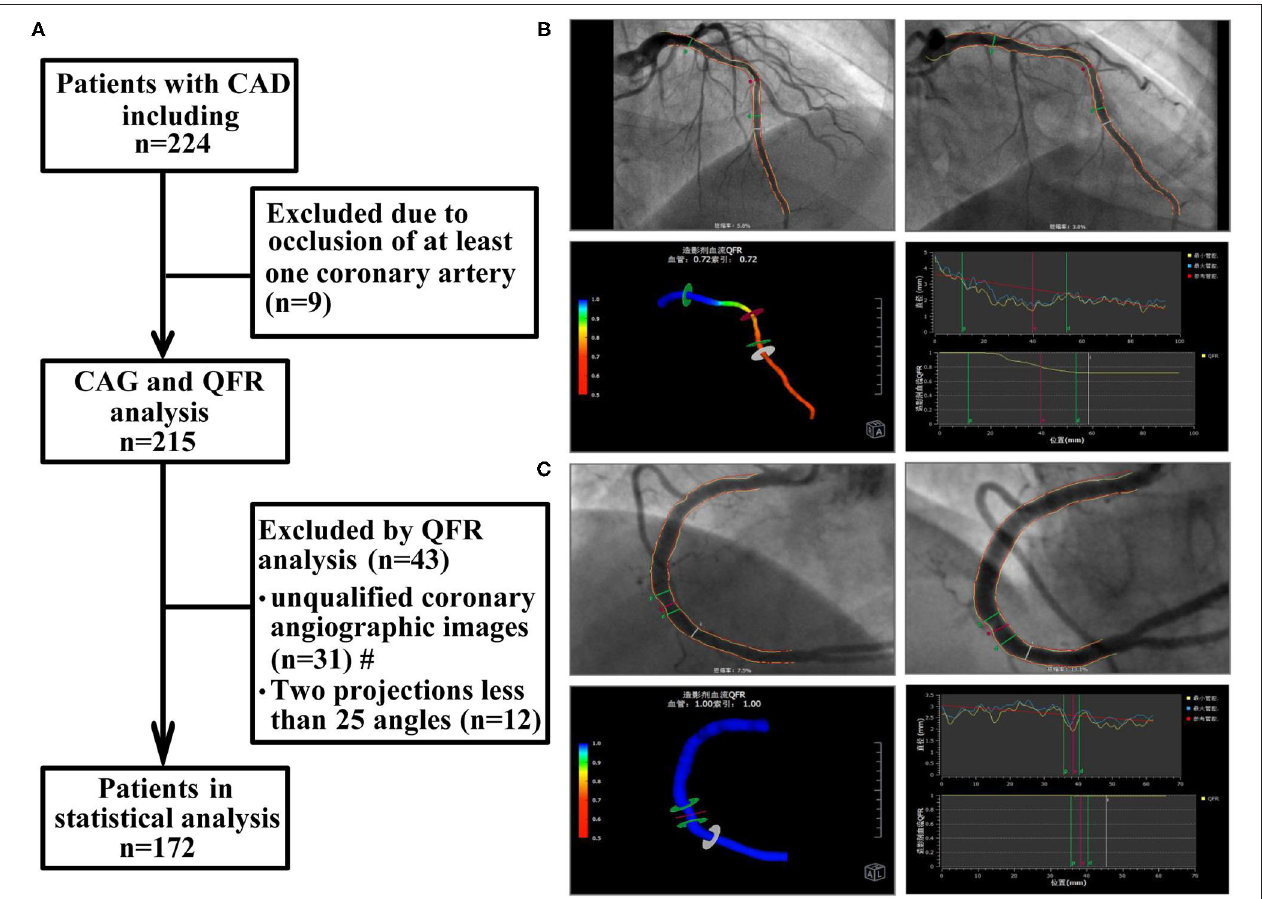
FIGURE 1 | Study flow chart and QFR analysis process. (A) Study flow chart. (B) The QFR of LAD was calculated as 0.72. (C) The QFR of RCA was calculated as 1.00. The QFR of LAD, the smaller of the two, was selected as the QFR of the target vessel. CAD, coronary artery disease; CAG, coronary arteriography; QFR, quantitative flow ratio. #: unqualified coronary angiographic images included ostial lesion, severe vessel tortuosity, diffuse long lesions, and poor coronary image quality.